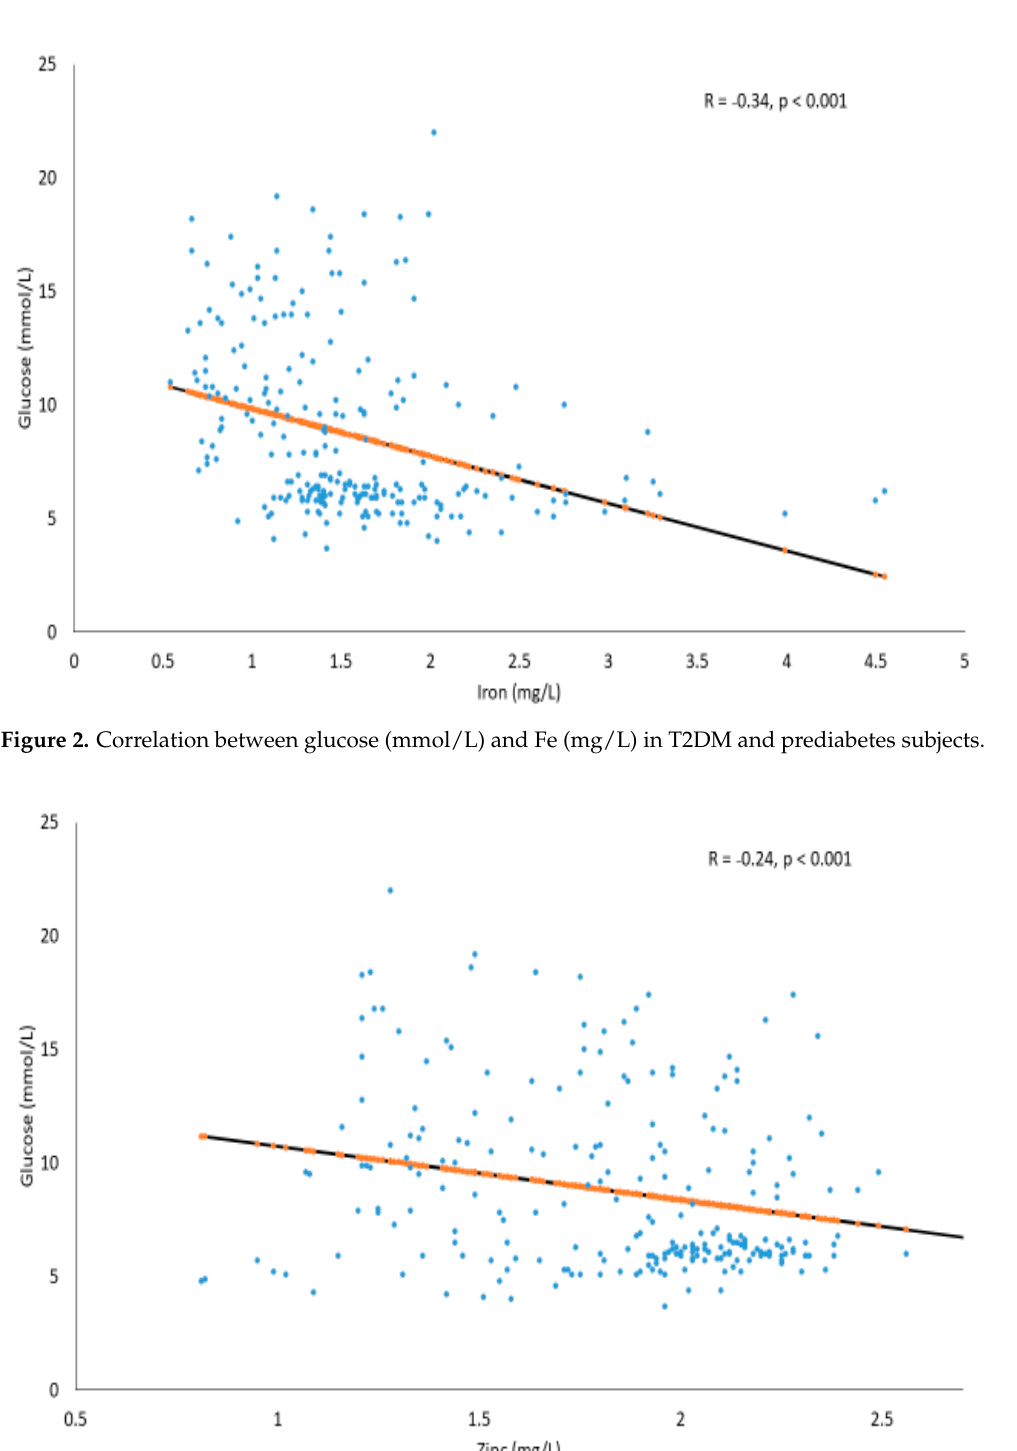
Figure 3. Correlation between glucose (mmol/L) and Zn (mg/L) in T2DM and prediabetes subjects.